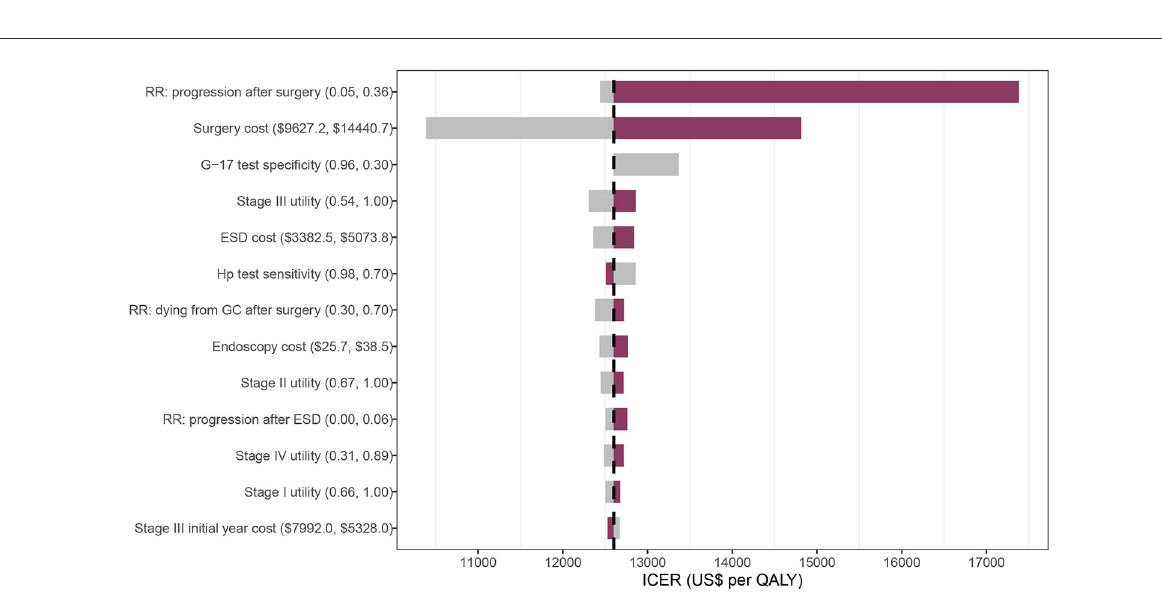
subgroups (Supplementary Figure S4). Obviously, almost all clinical outcomes performed best in the current smokers and Hp + subgroups (Supplementary Table S3). Compared with no screening, the GC stage distribution changed significantly in